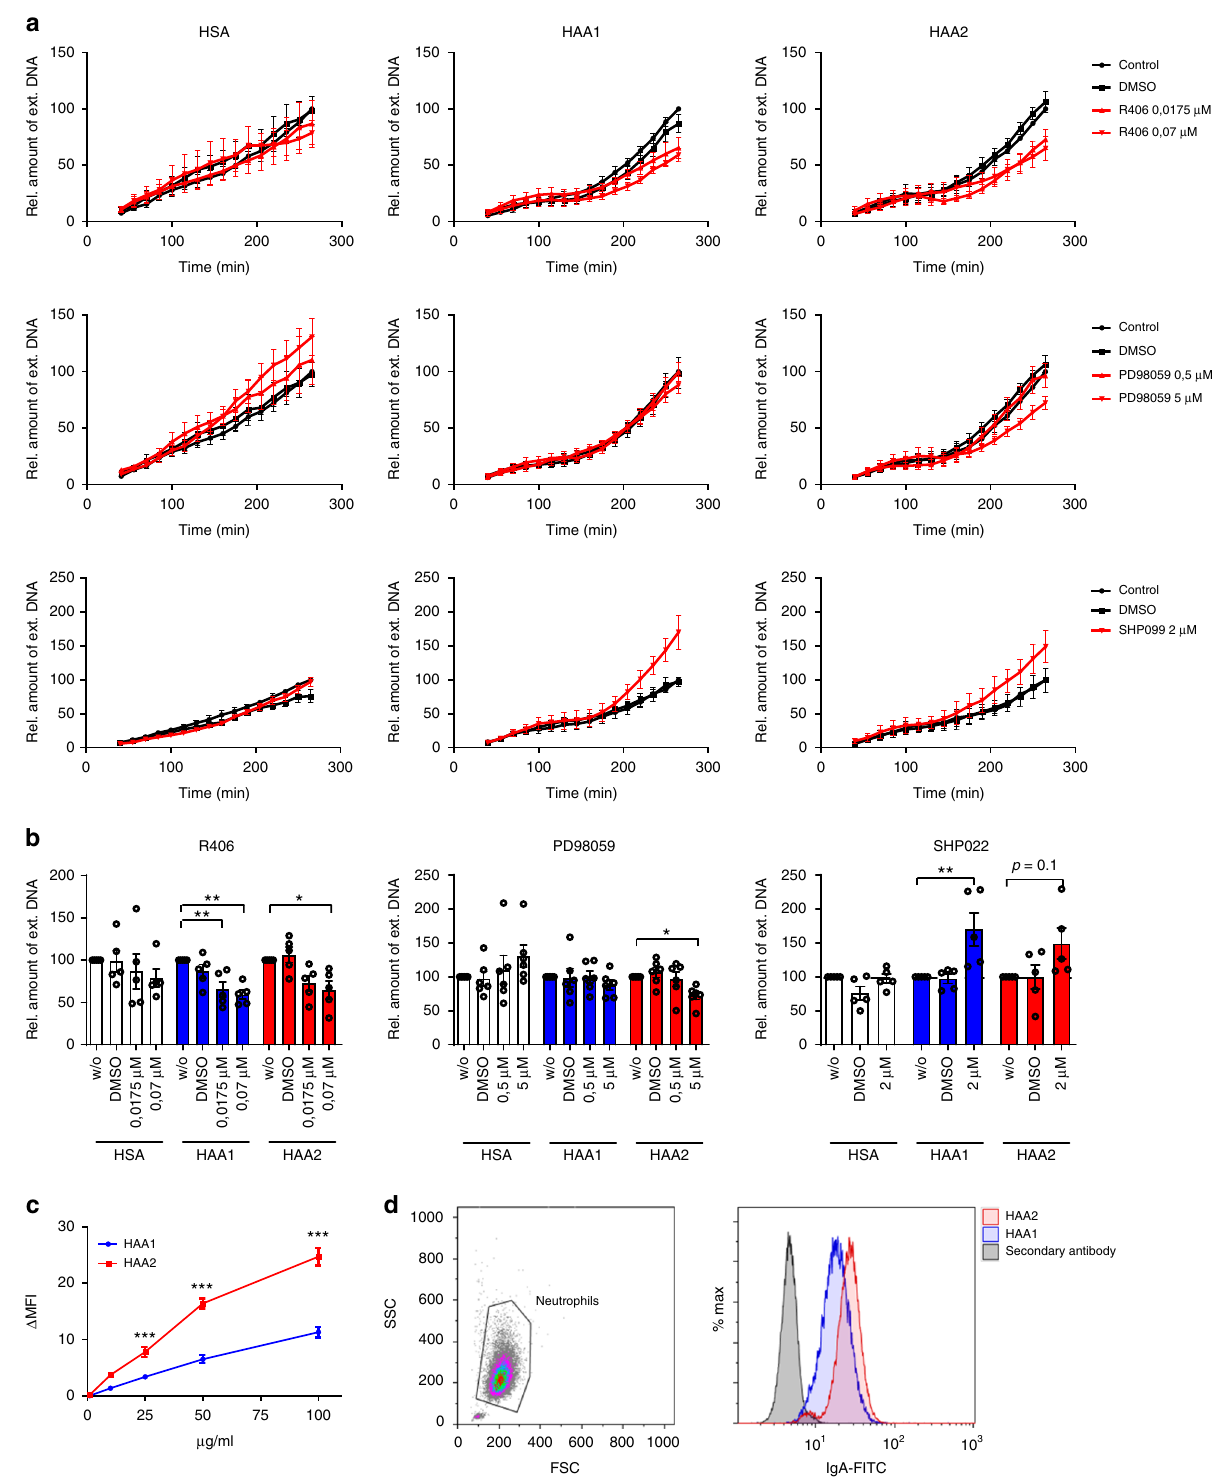
Fig. 2 IgA2 induces stronger binding and activating signaling to neutrophils than IgA1. a , b Human neutrophils were stimulated with 100 µ g/ml of heat aggregated IgA1 and IgA2 ( = HAA1 and HAA2) or with human serum albumin ( = HSA) in the presence of inhibitors for Syk ( = R406), Erk ( = PD98059) or Shp-2 ( = SHP099) at the indicated concentrations. Neutrophil extracellular trap (NET) formation was evaluated by staining extracellular DNA with Sytox Green. a NET formation over time and b relative amount of extracellular DNA at 265 min after stimulation normalized on treatment without inhibitors; n = 5 – 6 donors. c Binding of HAA1 and HAA2 to neutrophils measured by fl ow cytometry; n = 4 donors. d Representative blots of fl ow cytometry analysis showing neutrophil gating and fl uorescence intensity. FSC, forward scatter; SSC, side scatter. Signi fi cances were tested with paired one-way ANOVA followed by Dunnett ’ s correction b or Bonferroni correction for selected pairs of columns c . * p < 0,05; ** p < 0,01; and *** p < 0,001. Data are presented as mean ± s.e.m. a , c or scatter blots with bars showing mean ± s.e.m. b . Source data are provided as a Source Data fi